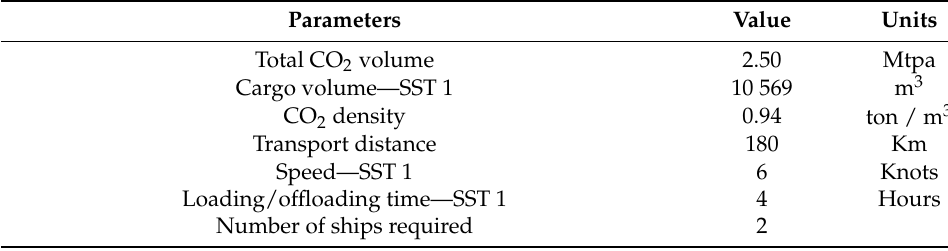
The cost of CO 2 per tonne is calculated using Equation (A9).